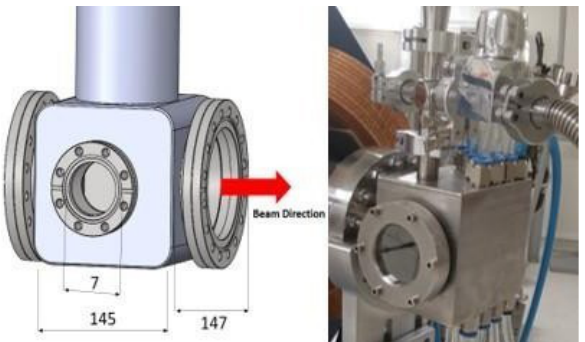
Fig. 14. A 3-D drawing of the movable beam screen designed to observe the proton beam profile. The image of the beam can be viewed from the window which has 7 cm radius (Left). Fixed Beam screen of METU-DBL which is used for pretest. Also the radius of fixed beam screen is 7 cm. (All dimensions are given in millimeters).